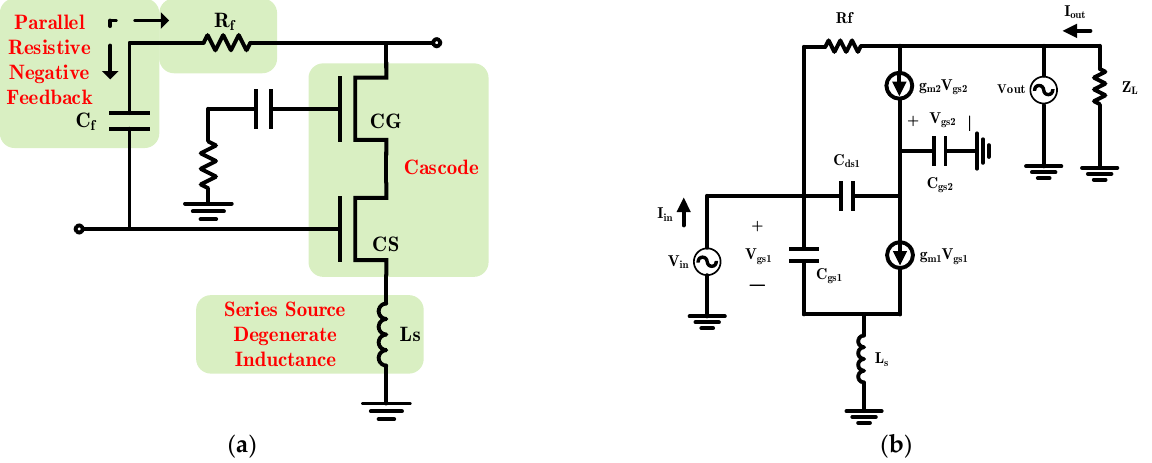
Figure 2. ( a ) Cascode with dual feedbacks; ( b ) The small-signal equivalent model of ( a ). For the series inductor L s at the source terminal of C S , a real impedance is introduced to help meet the requirement of input matching and noise matching. In theory, simultaneous noise and input impedance matching can be attained. And there is no impact on the noise performance in the case of ideal inductance [23]. However, due to the non-ideality associated with Ls, additional noise will be introduced to the amplifier. It is necessary replaced by microstrip lines.